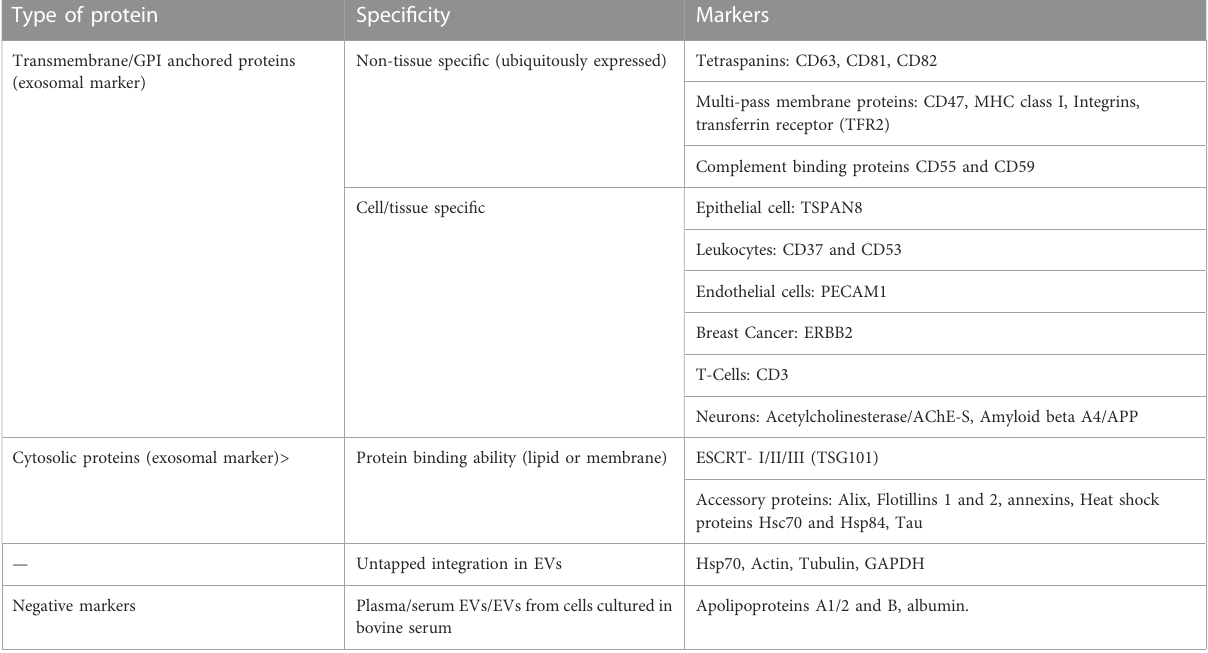
TABLE 5 This table summarizes different markers by which EVs could be characterized (reviewed in (Théry et al., 2018)). According to MISEV, at least three positive markers,including atransmembrane/lipidboundprotein andcytosolic protein,andonenegative markershouldbeshowntocharacterize exosomes in the EV fraction along with data from two other techniques like electron/atomic force microscopy and single particle analysis etc (Théry et al., 2018). Type of protein